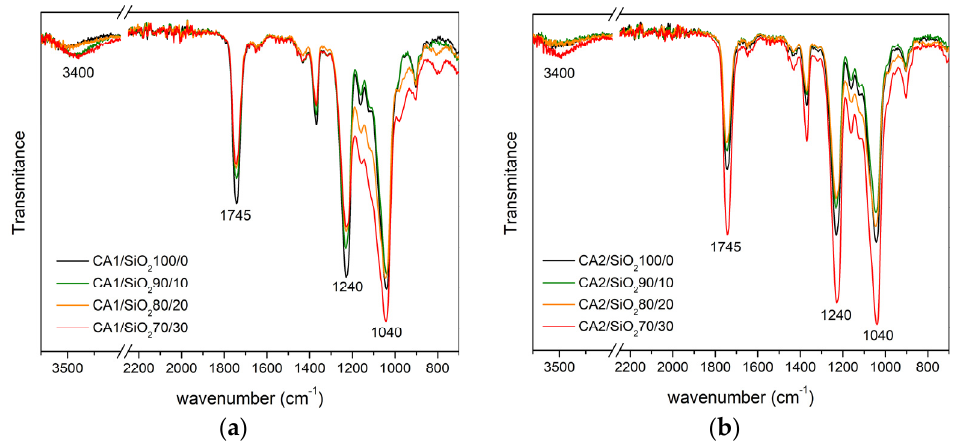
Figure 6. FTIR-ATR wide spectra (3750–700 cm -1 ) of the membranes in series one ( a ) and series two ( b ). two ( b ).